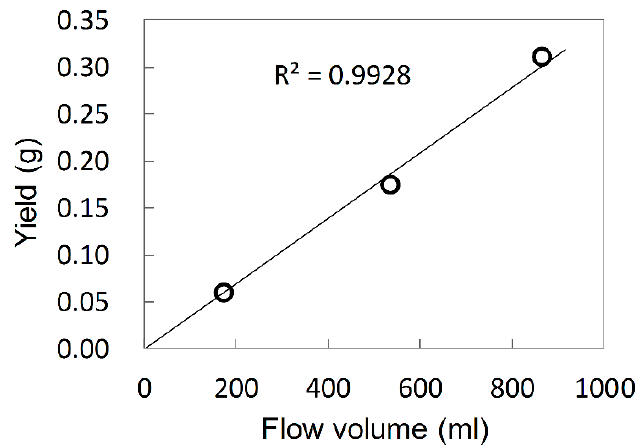
Figure 4. Scalability test in LSF propylene polymerization. The tube length was fixed at 0.15 s, while the cumulated flow volume was increased [21].